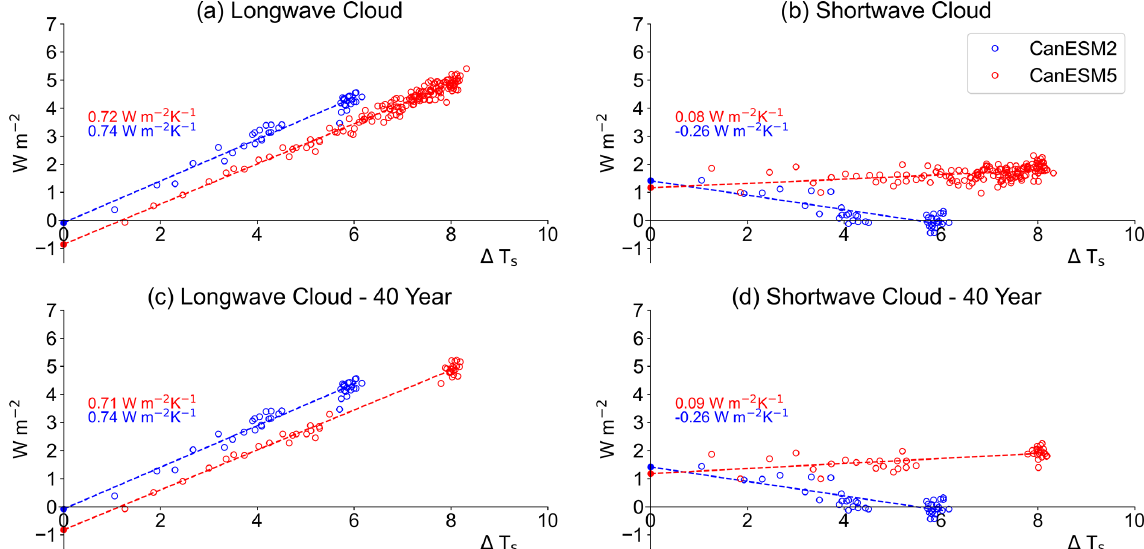
Figure A2. Cloud longwave and shortwave flux plotted against global annual mean surface temperature change in abrupt 4 × CO 2 simulations for CanESM2 (blue) and CanESM5 (red), calculated using the cloud radiative kernel method. Standard 150-year Gregory regressions are conducted, where the slope of the regression line equals the cloud feedback (in Wm − 2 K − 1 ). Panels (a) and (b) show regressions using all available years of data for each model version, whereas panels (c) and (d) show subsampled data for CanESM5 (years 1–20 and